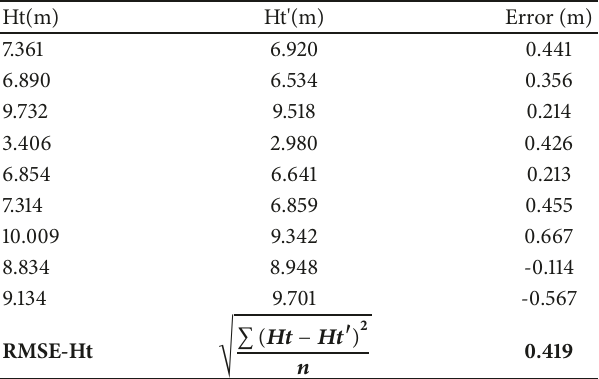
Table 5: Error and root mean square error for height